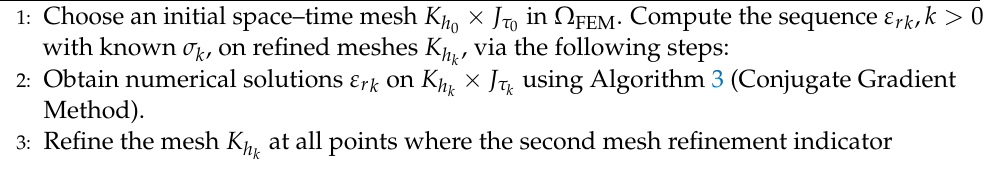
Algorithm 5: Adaptive Algorithm, second